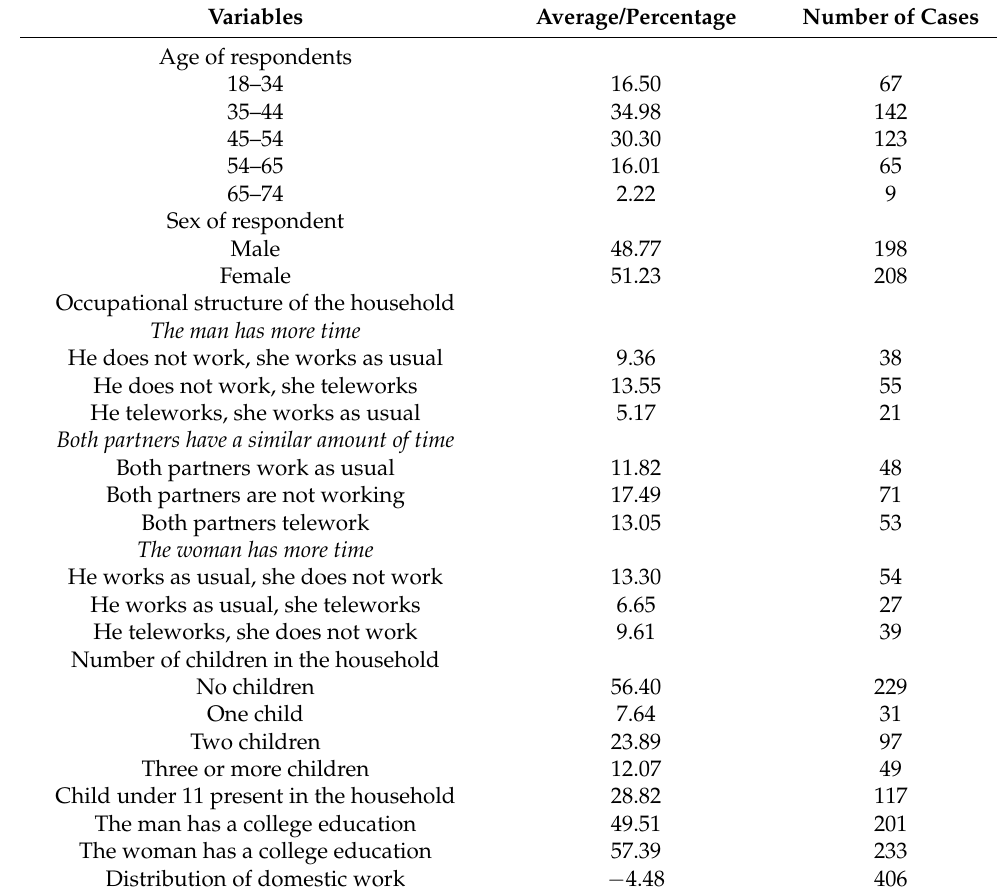
Table 1. Sample distribution (weighted, N =